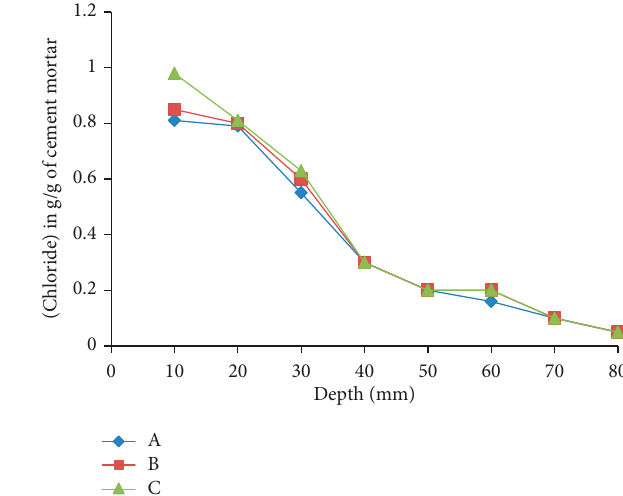
Figure 13: Chloride profiles at w/c 0.6.